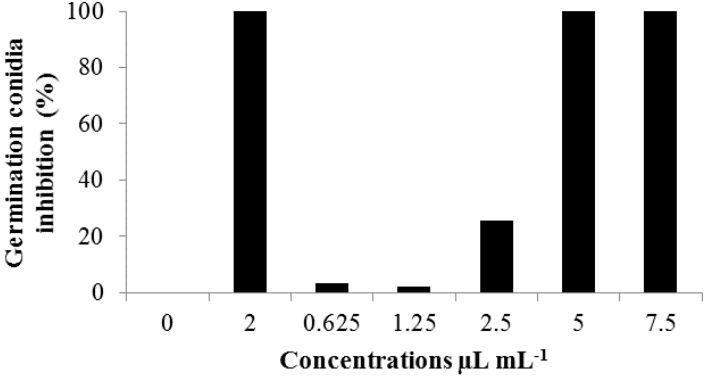
Figure 3. Conidia germination inhibition of Curvularia lunata under crescent dosages of C. citratus ( Cymbopogon citratus ) essential oil. Treatments: 0 (0.0 μ L mL − 1 ), 2 (Negative control, with methyl ‐ thiophanate 2 mg mL − 1 ). Concentrations of C. citratus essential oil = 0.625 μ L mL − 1 ; 1.25 μ L mL − 1 ; 2.5